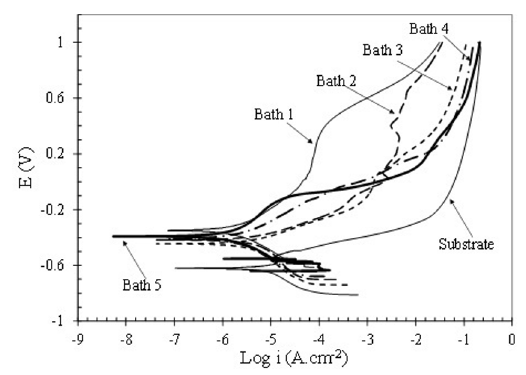
Figure 9. Surface roughness of the coatings produced in baths 1 to 5 in the as-deposited and annealed conditions.